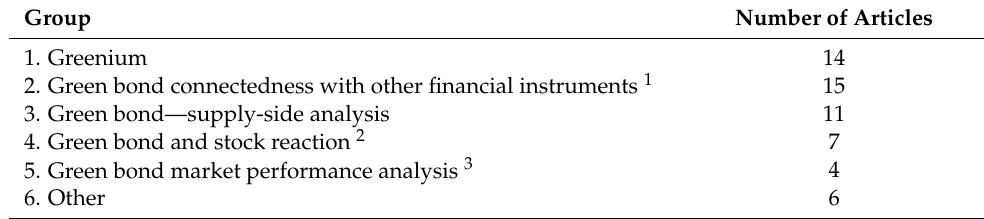
Table 4. Taxonomy of green bonds empirical literature.